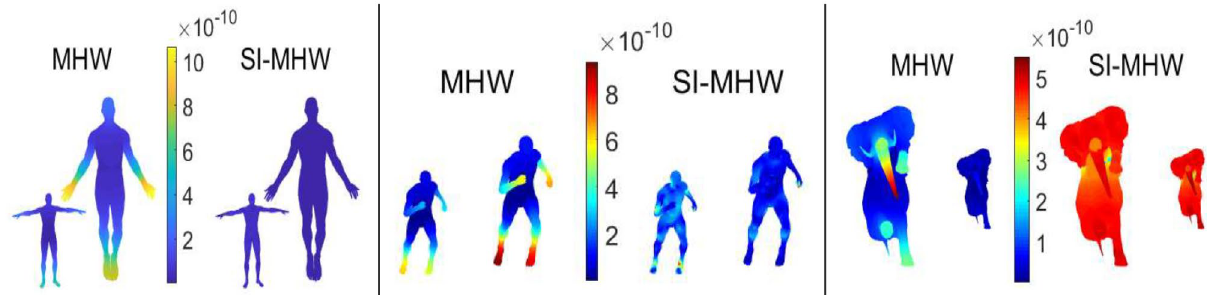
Figure 3. Comparison of MHW (left) and the proposed SIMHW (right)